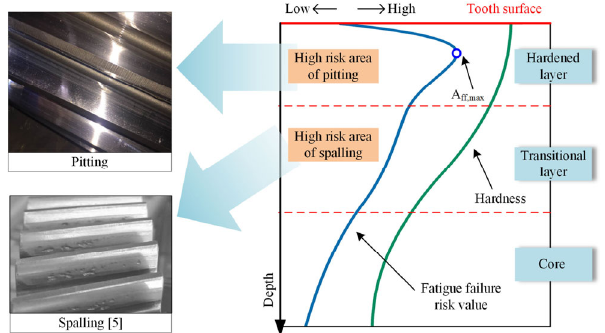
Fig. 4 Zones with different failure modes on a gear fatigue risk map.